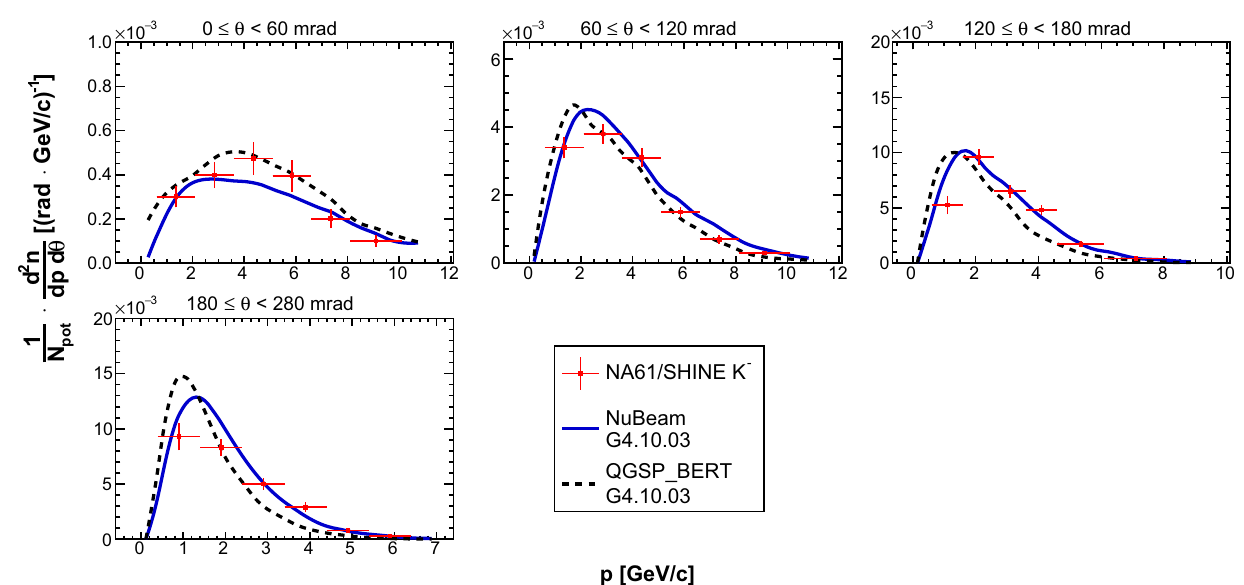
Fig. 41 Double differential yields of negatively charged kaons for the mostupstreamlongitudinalbin(0 ≤ z < 18cm).Verticalbarsrepresent the total uncertanties. Predictions from the NuBeam (solid blue line)